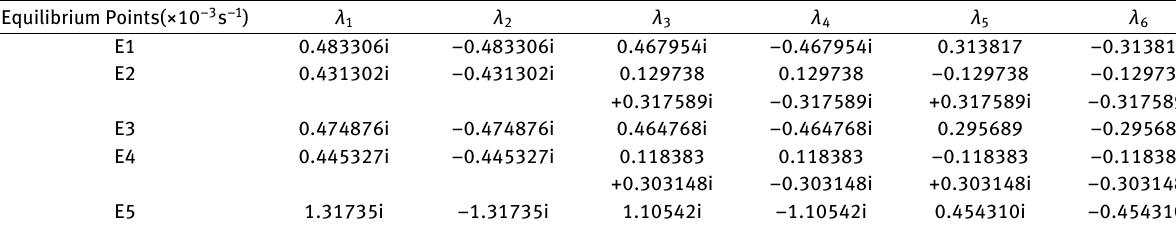
Table 2. Eigenvalues of the equilibrium points around 22